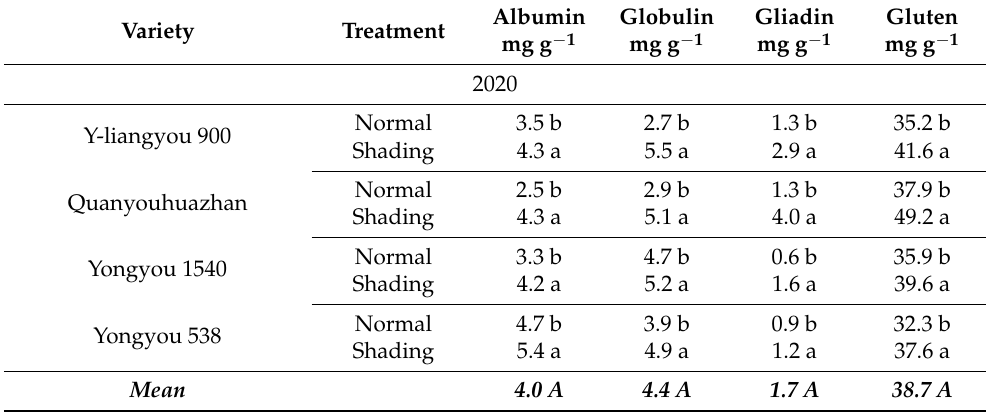
Table 5. Protein components of different rice varieties under shading after flowering in 2020–2021.